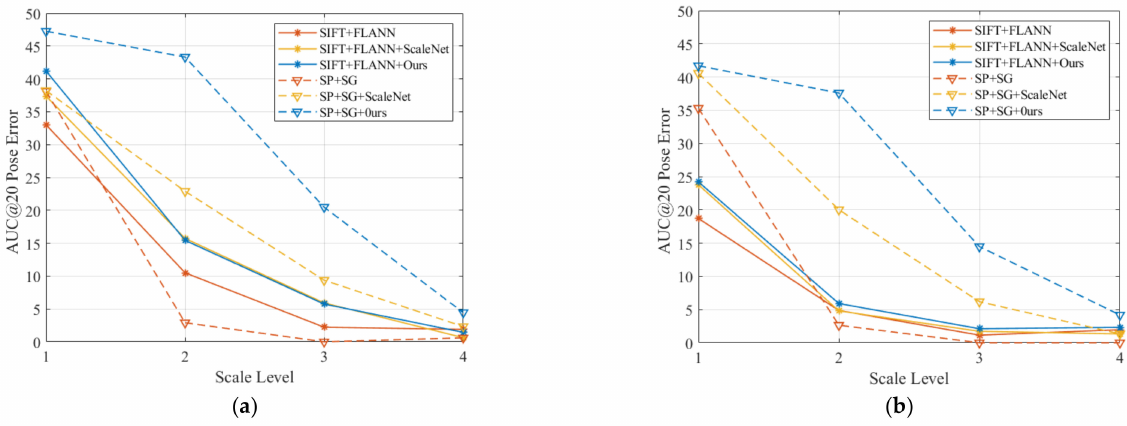
Figure 12. The Error of Relative Pose Estimation In The FixedLight Dataset And VariableLight Dataset. ( a ) FixedLight Dataset, ( b ) VariableLight